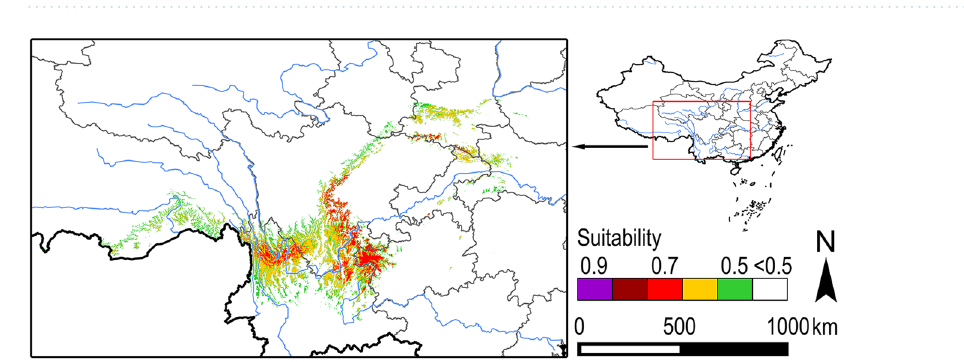
Figure 3. Suitable areas for B. thaidina in China under current climate